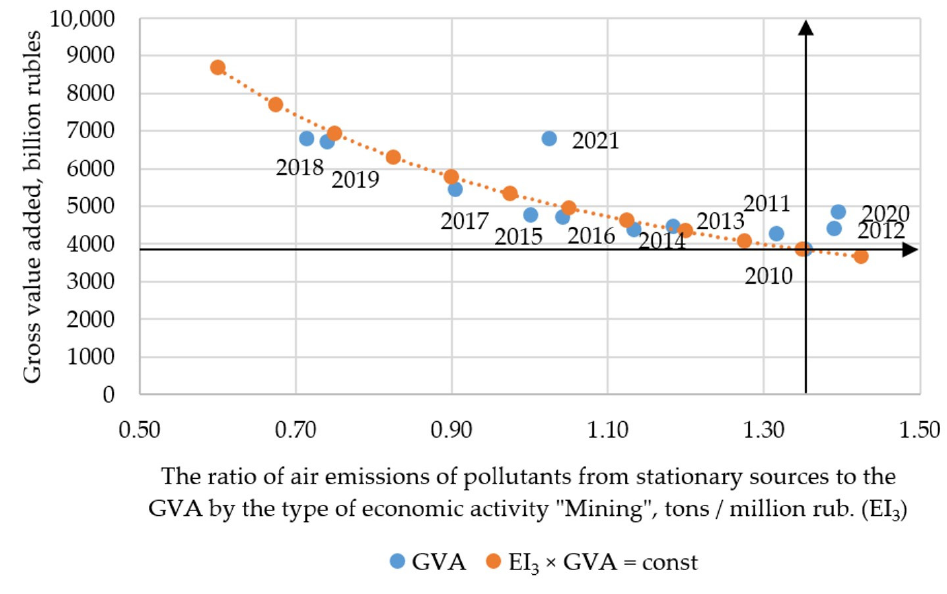
Figure 4. The color of environmental and economic development in terms of emissions into the atmosphere of pollutants from stationary sources by type of economic activity “Mining” in the Russian Federation for the period 2010–2021.